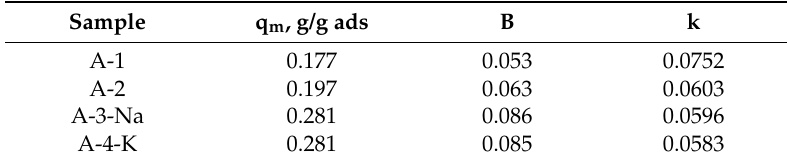
Table 3. Characteristics of the kinetic curves of the adsorption and desorption of water vapor on the alumina